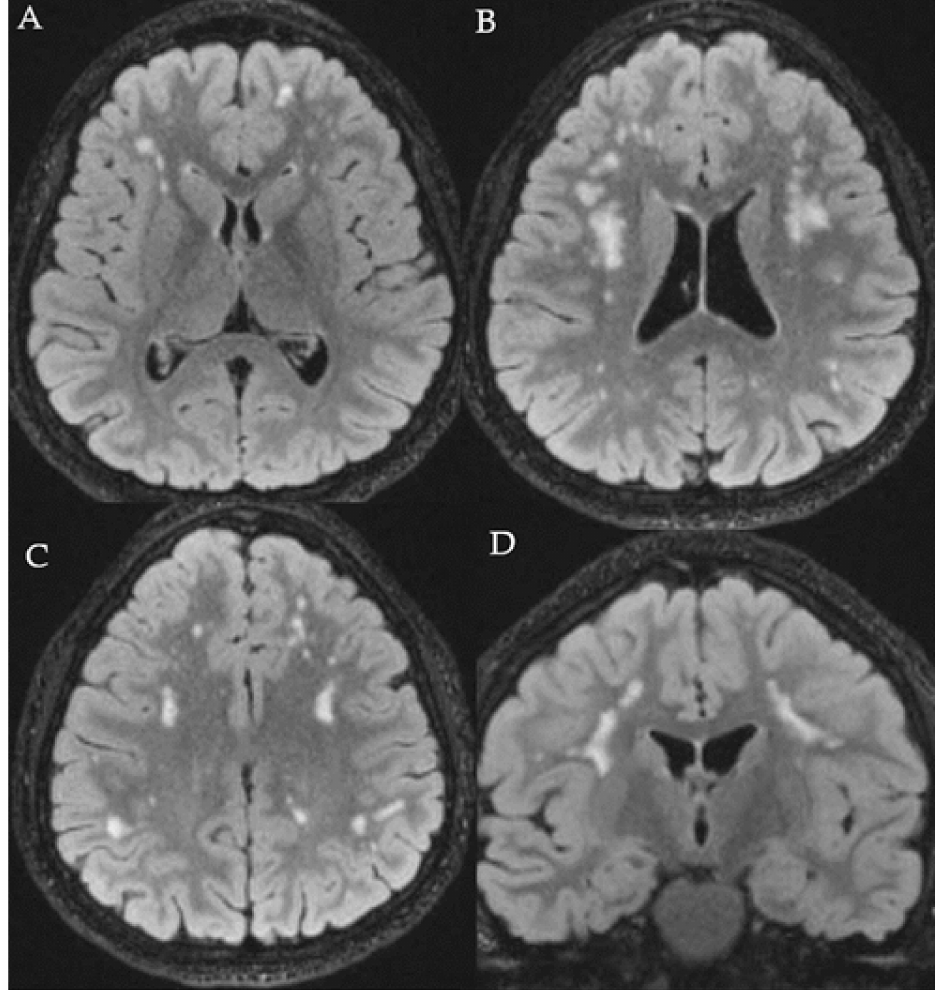
Figure 2. Brain MRI of the patient axial ( A – C ) and coronal ( D ) FLAIR images show multifocal and confluent abnormalities in the subcortical white matter of the frontoparietal lobes; stable during the